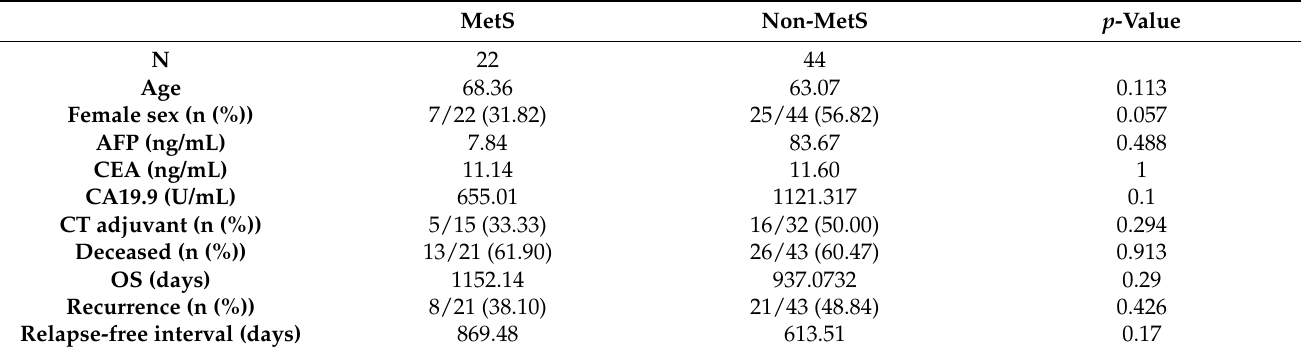
Table 2. Demographic and clinical characteristics of iCCA with and without